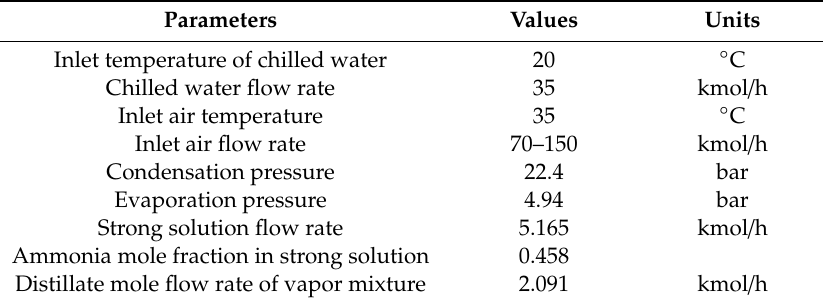
Table 2. Components and their corresponding modules with input data.